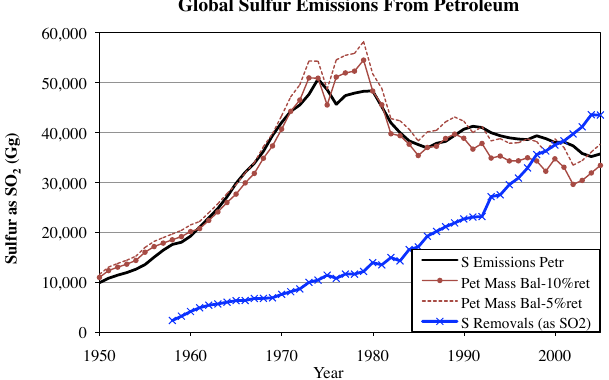
Fig. 2. Global petroleum emissions from the present inventory com- pared to estimates from a global crude oil mass balance (see text) us- ing two different assumptions for the fraction of total sulfur retained in non-combusted products. The inventory data include terrestrial and international shipping combustion and process emissions from refineries. Also shown is the estimated global amount of sulfur re- moved at refineries (as Gg SO 2